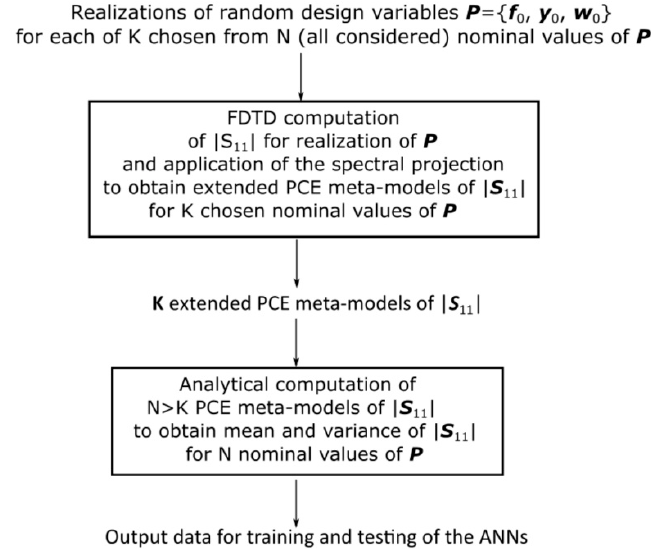
Figure 11. Diagram of a method for FDTD-PCE computations of the mean and standard deviation of | S 11 | for N nominal values of random design variables P . | S 11 | for N nominal values of random design variables P